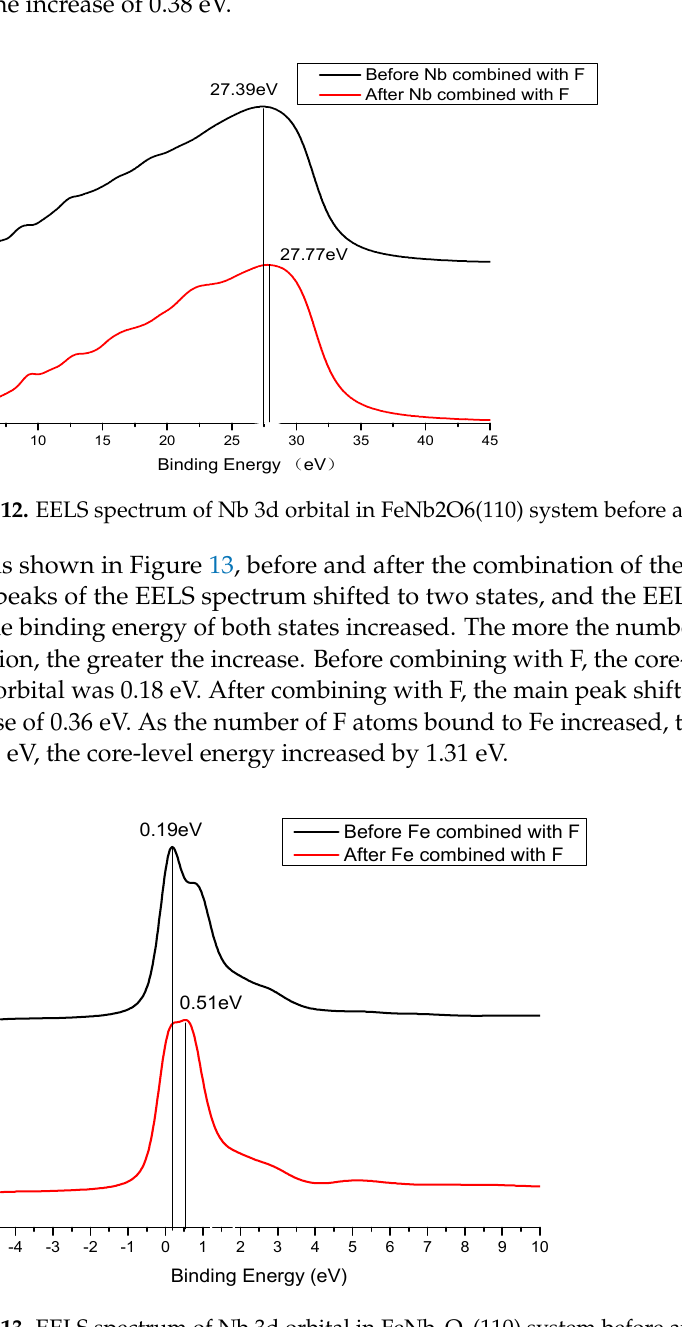
with the increase of 0.38 eV.